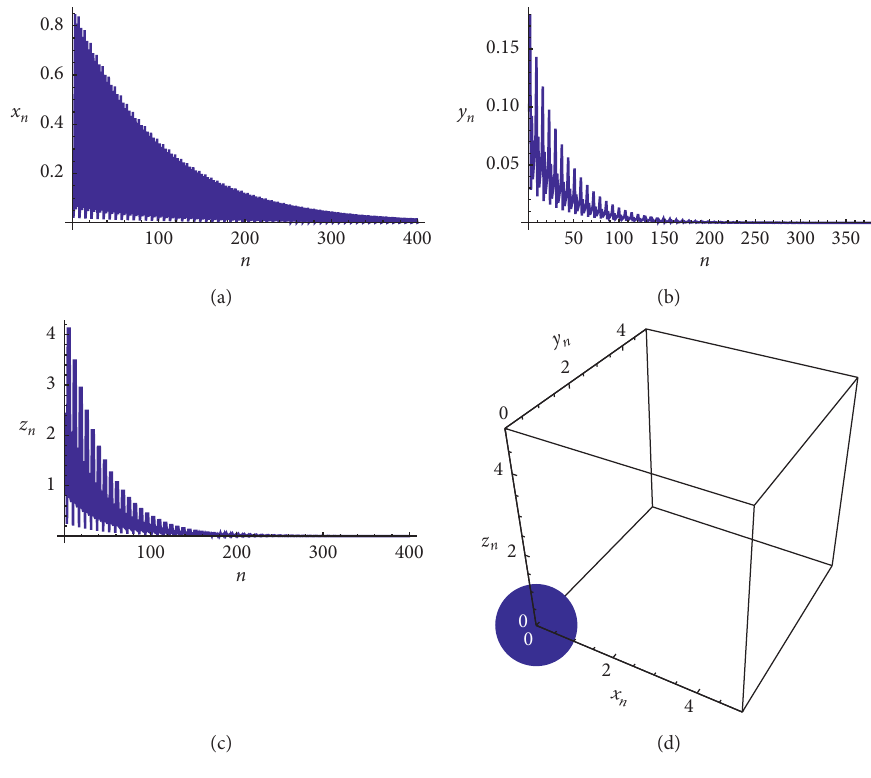
Figure 3: Dynamics of